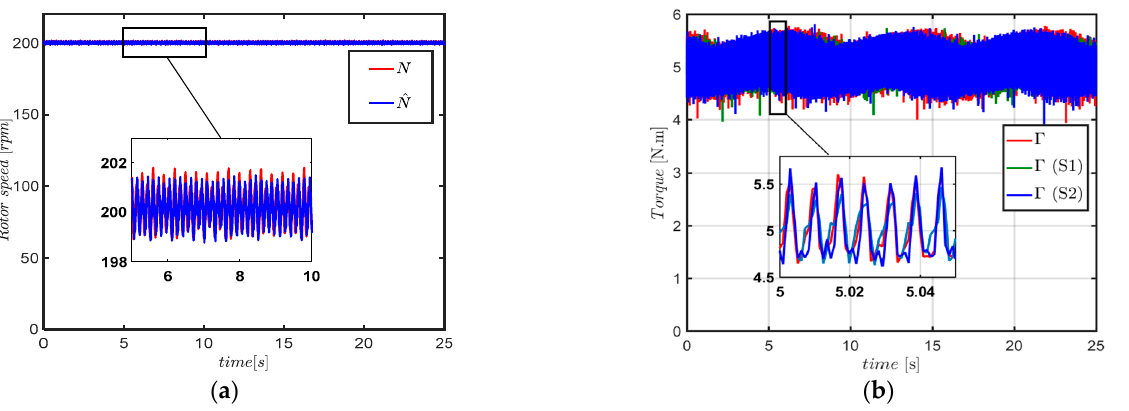
Figure 26. Experimental waveforms: ( a ) measured and estimated rotor speed, ( b ) measured torque when the seven-phase PMSM is controlled by the encoder, sensorless control ( S1 ), and sensorless control ( S2 ) .